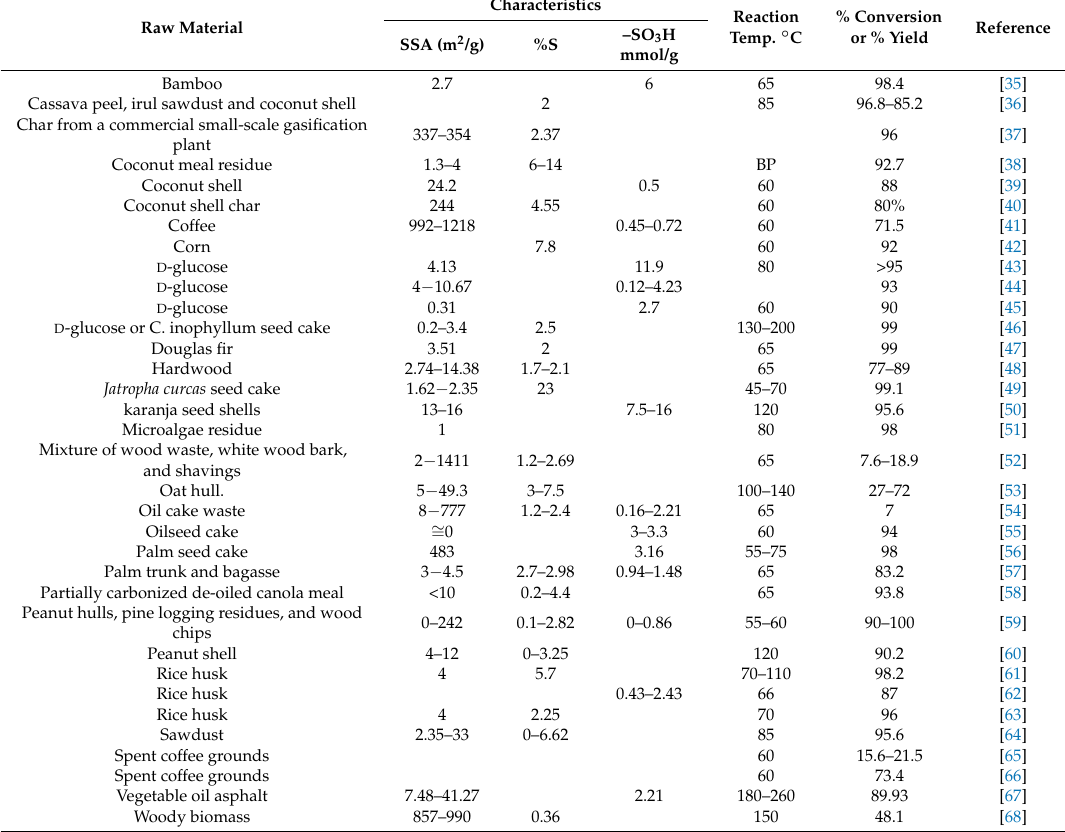
Table 1. Use of solid biochars as catalysts for transesterification/esterification reaction in biodiesel